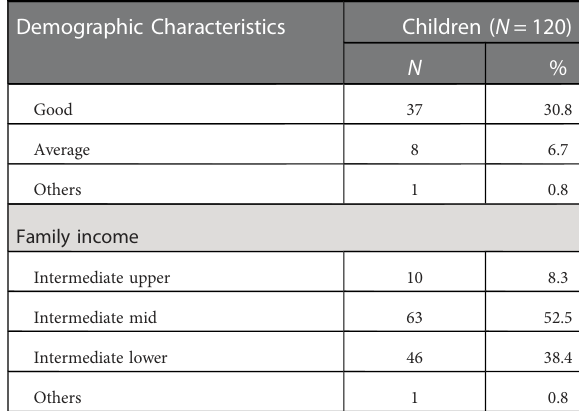
TABLE 1 Demographic characteristics of the sample.